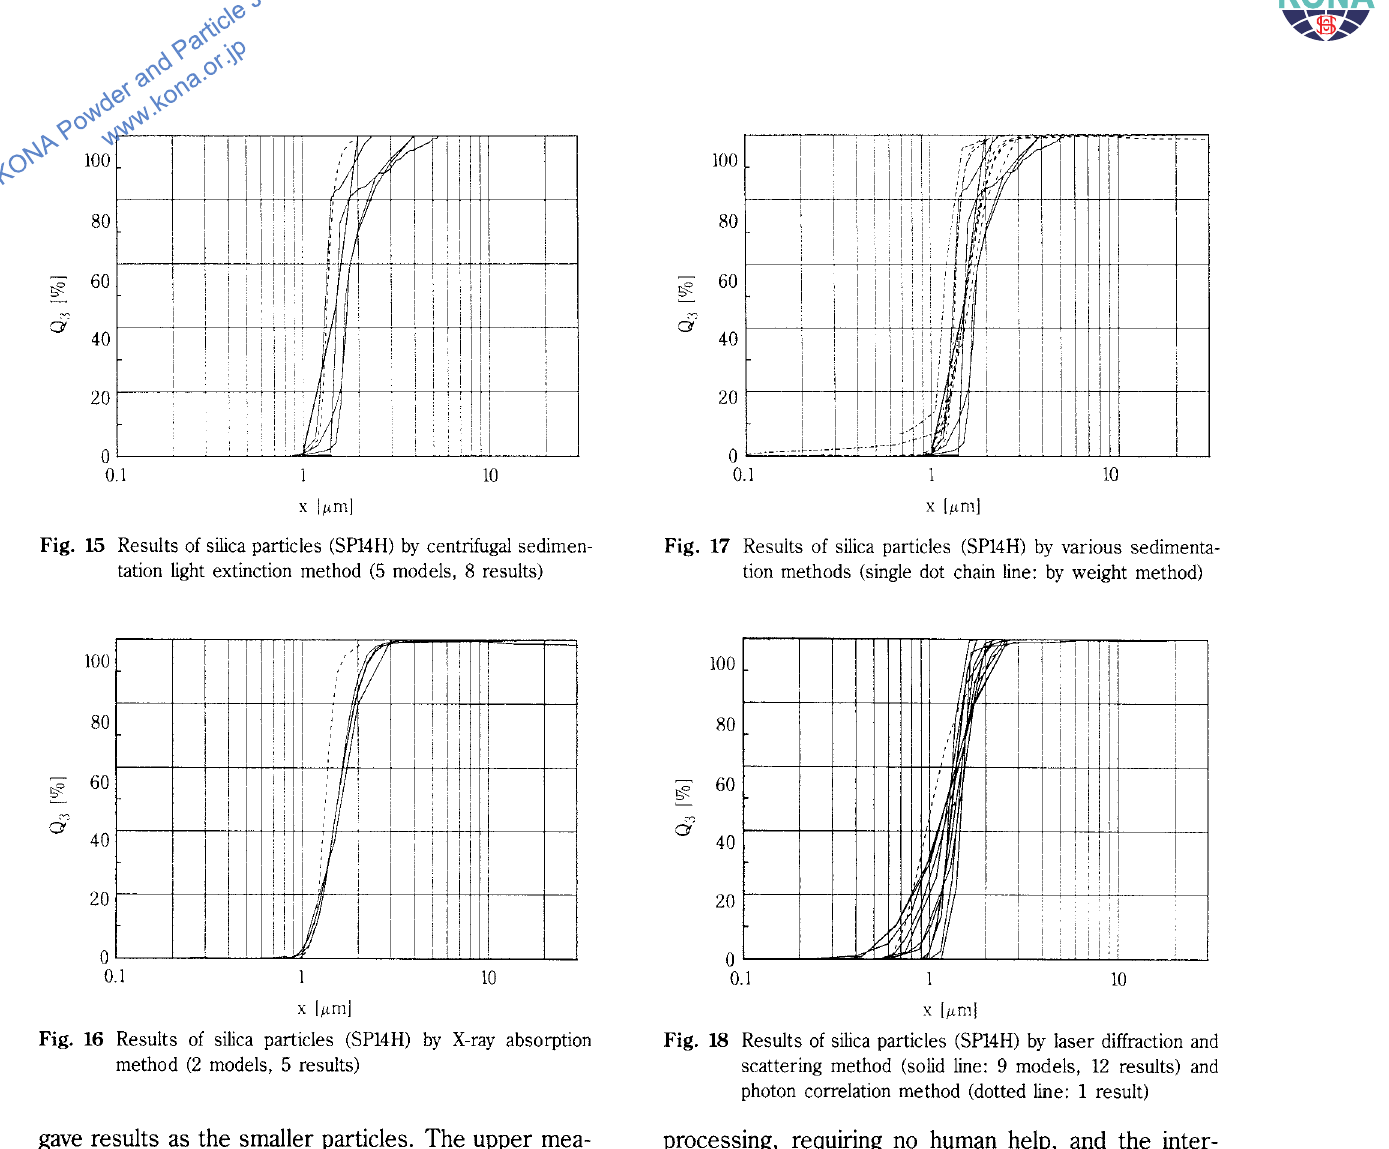
Fig. 16 Results of silica particles (SP14H) by X-ray absorption method (2 models, 5 results)